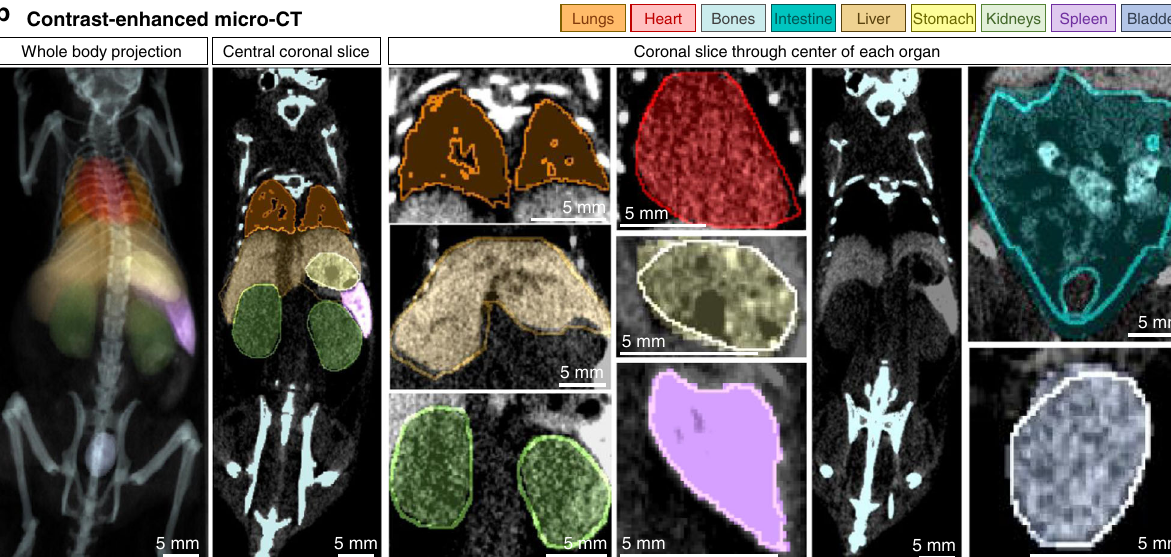
Fig. 3 Qualitative results of segmentation performance. Filled, semi-transparent areas show AIMOS prediction for a native micro-CT and b contrast- enhanced micro-CT. Opaque lines indicate human expert annotations. Left column shows mean-intensity projections for the whole-body scan. Second column shows representative coronal slices. Remaining columns of fi gure show individual organs (coronal slice through center of organ). The intestine segmentations are not displayed in the whole-body projections as they would occlude other organs due to their size and